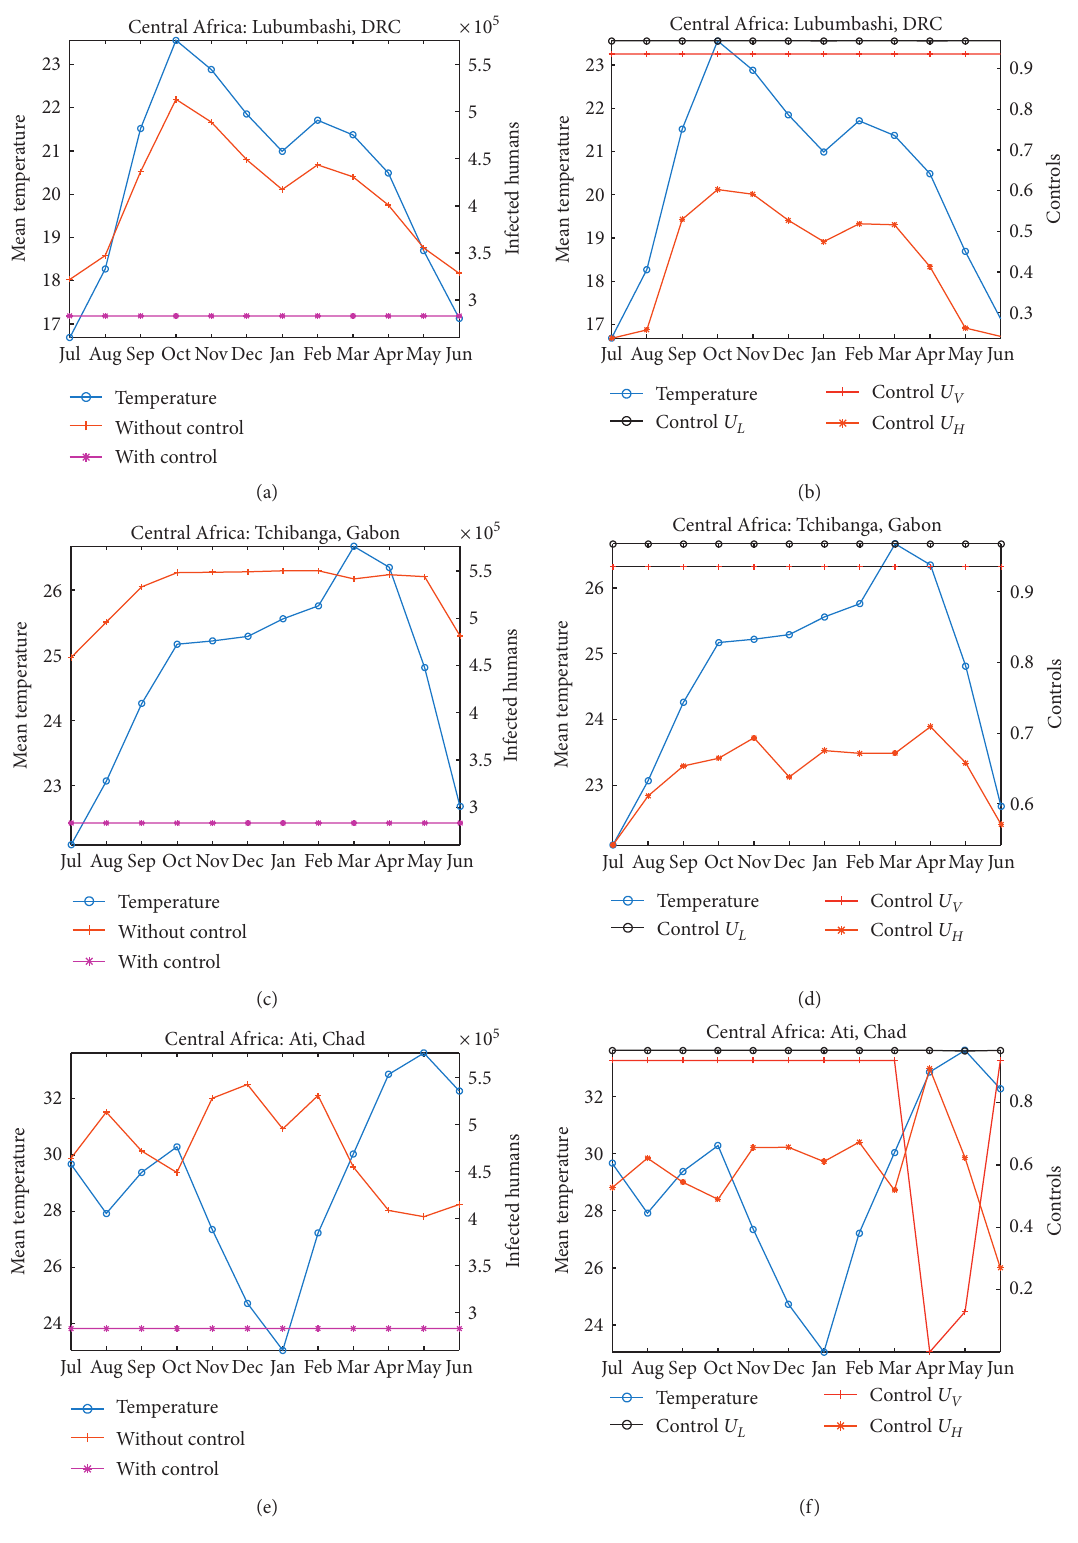
Figure 6: Simulations of the model (2) as a function of time: (a, c, e) the monthly total number of infected humans without and with controls and (b, d, f) optimal controls u H ( t ) ,u L ( t ) , and u V ( t ) , in Lubumbashi, DRC; Tchibanga, Gabon; and Ati, Chad; all Central Africa. The mean monthly temperature is plotted in blue lines and is superimposed onto each